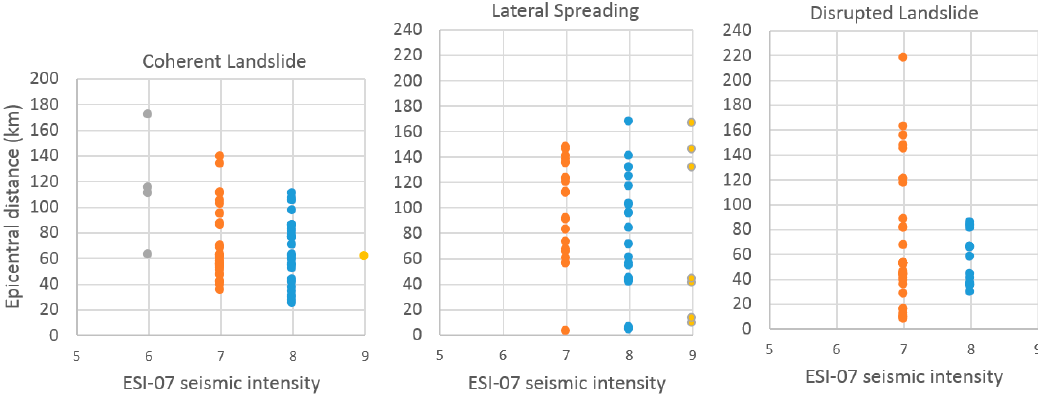
Figure 11. Relationship between epicentral distance, landslide types and ESI-07 seismic intensity.